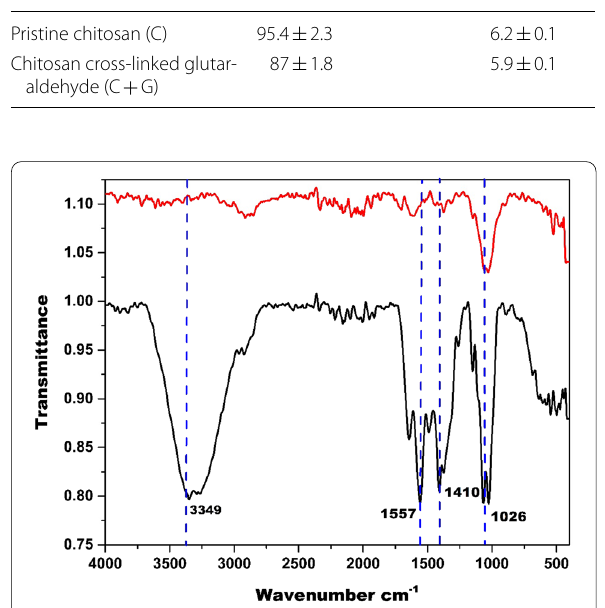
Fig. 1 The FTIR spectra of C and C